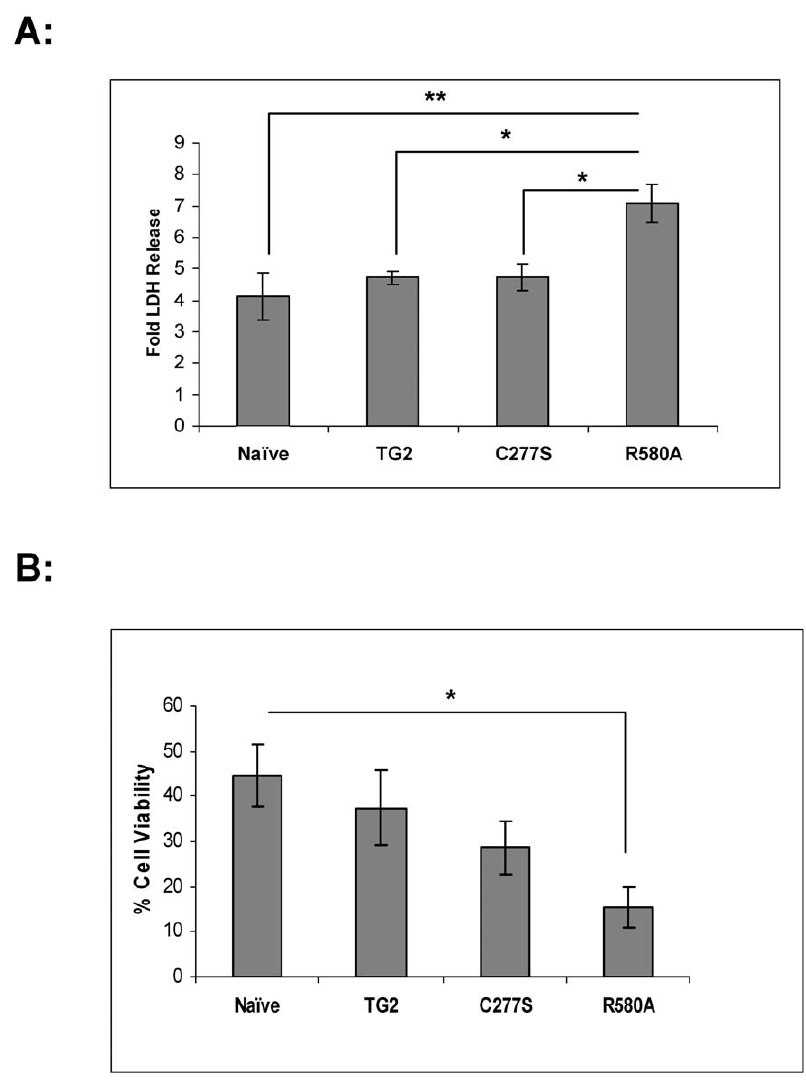
Figure 5. OGD-induced cell death. A , Fold LDH release after 36 h of OGD at 0.1% O 2 . TG2-R580A (R580A) cells showed significantly higher fold LDH release than other cell lines after OGD treatment. (N=6) B , Calcein AM cell viability assay after 24 h OGD treatment at 0.1% O 2 . TG2-R580A (R580A) cells showed significantly lower cell viability after OGD treatment. (N=6) Results are shown as mean + / 2 SE, *p , 0.05, ** p , 0.01.